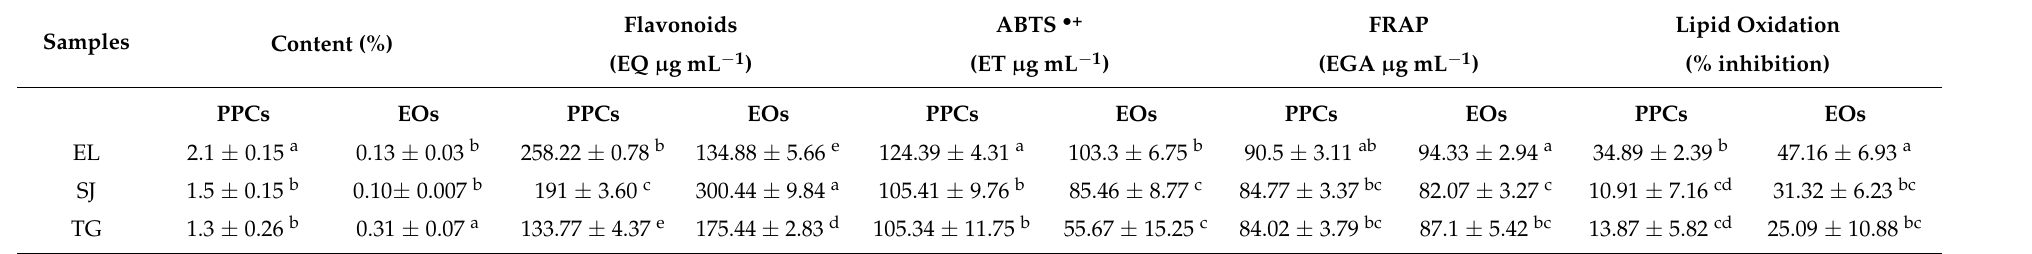
Table 1. PPCs and EOs content, flavonoids, and antioxidant